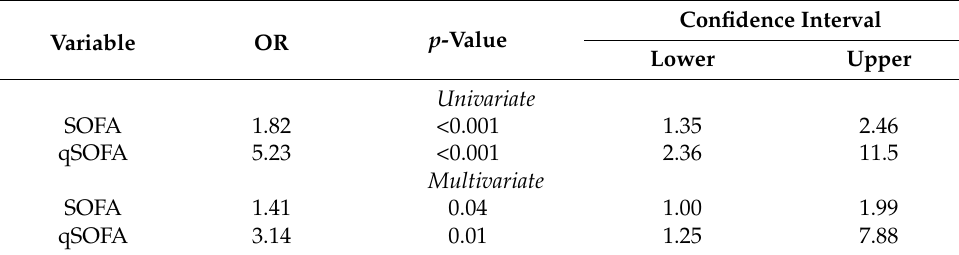
Table 4. Univariate and multivariate logistic analysis for inpatient death of COVID-19. Confidence Interval Variable OR p -Value Lower Upper Univariate SOFA 1.82 <0.001 1.35 2.46 qSOFA 5.23 <0.001 2.36 11.5 Multivariate SOFA 1.41 0.04 1.99